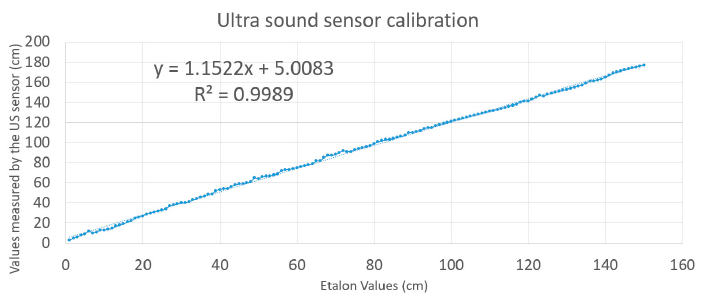
Figure 9. Ultrasound sensor calibration and model fitting.